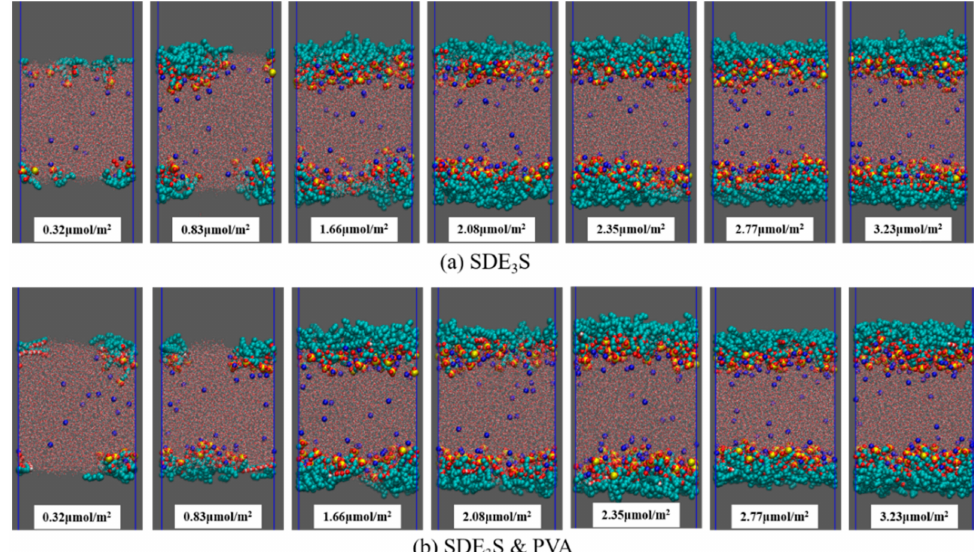
Figure 7. Final configurations at the end of simulations: ( a ) SDE 3 S systems; ( b ) SDE 3 S / PVA